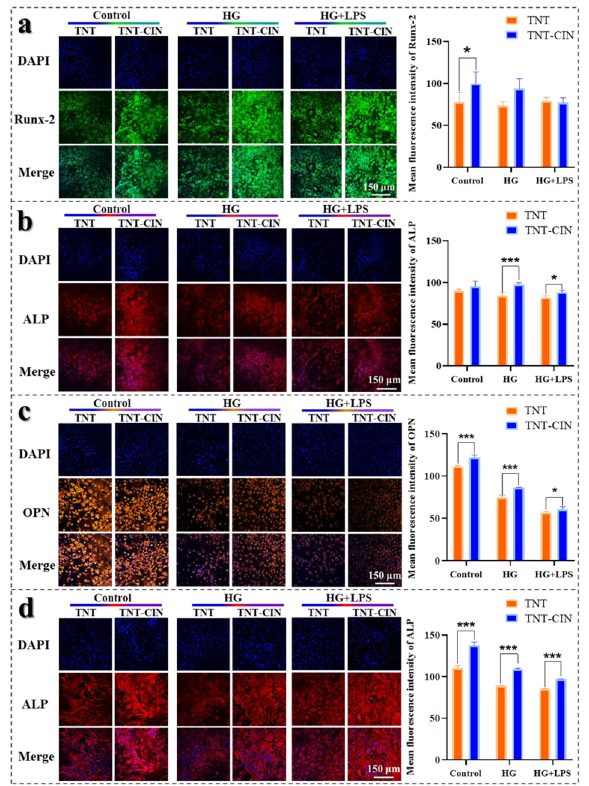
Fig. 3 The expression of osteogenic proteins restrained by comprised condition appeared to be higher on TNT-CIN than on TNT. a , b The immuno fl uorescence staining of Runx-2 and ALP observed by con- focal scanning laser microscopy after osteogenic induction for 7 days and its semi-quantitative analysis by Image J. c , d The immuno- fl uorescence staining of OPN and ALP observed by confocal scanning laser microscopy after osteogenic induction for 14 days and its semi- quantitative analysis by Image J. *P < 0.05, ** P < 0.01, *** P < 0.001. Scale bar = 150 μ